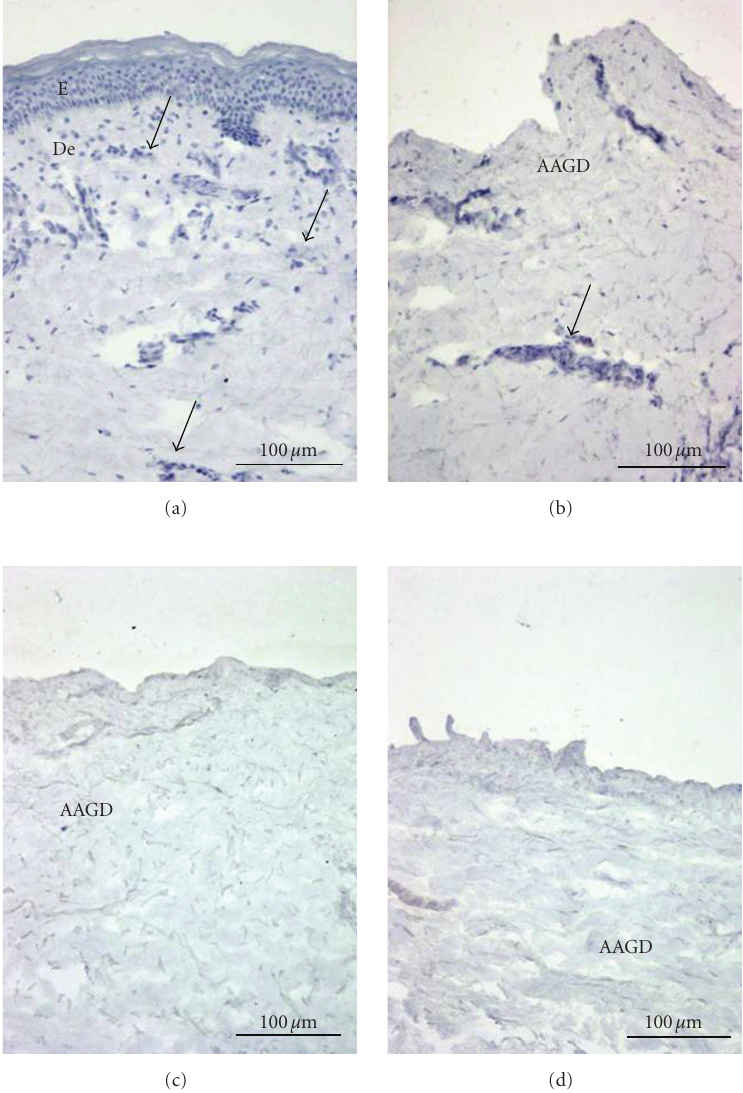
Figure 4: Histomorphological analysis performed on the de-epithelialized dermis to verify the integrity of the tissue architecture and determine the cell presence over time. Sections were stained with Mayer’s hematoxylin solution. (a) at day 0, after the glycerol removal and before the de-epithelialization: arrows indicate the presence of infiltrating cells; (b) at 2 days, (c) at 7 days, (d) at 14 days. The number of ghost cells decrease constantly over time and are no longer present as from 7 days. Original magnification: 10x. E: epidermis, De: dermis, AAGD: alloplastic acellular glycerolized